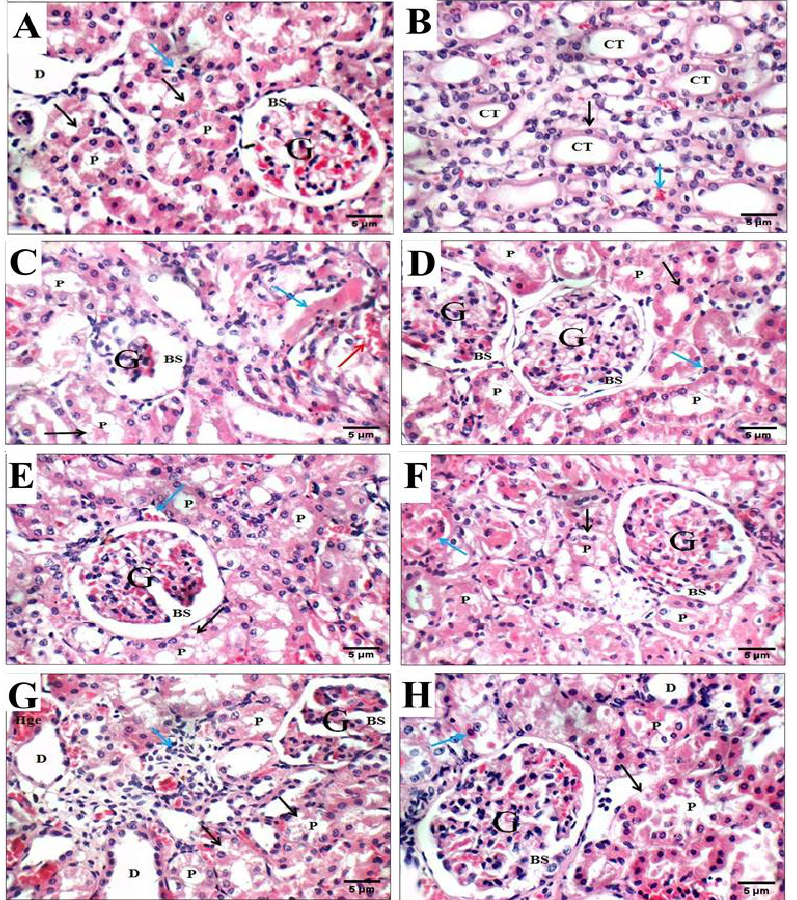
Fig. 4. The effects of fig with olive oil and date-palm fruit extracts (FOD) on the microscopic histological appearance of livers treated with different nanoparticles (NPs) for 75 days. A , higher power view of the control kidney showing average glomeruli (G) with average Bowman’s spaces (BS), average proximal tubules (P) with preserved brush borders (black arrows), average distal tubules (D), and average interstitium (blue arrow); B , FOD- treated group renal medulla showing average collecting tubules (CT) with average epithelial lining (black arrow) and average peri-tubular capillaries (blue arrow); C , SiO NPs-treated group showing atrophied glomerulus (G) with 2 widened Bowman’s space (BS), proximal tubules (P) with mildly edematous epithelial lining (black arrow), intra- tubular hyaline casts (blue arrow), and mildly congested blood vessels (red arrow); D , FOD-SiO NPs-treated group 2 showing average glomeruli (G) with average Bowman’s spaces (BS), proximal tubules (P) with average epithelial lining (black arrow), and average interstitium (blue arrow); E , Al O NPs-treated group showing average glomerulus 2 3 (G) with average Bowman’s space (BS), proximal tubules (P) with mildly edematous epithelial lining (black arrow) and mildly congested interstitial blood vessels (blue arrow); F , FOD-Al O NPs-treated group showing average 2 3 glomerulus (G) with average Bowman’s space (BS), proximal tubules (P) with mildly edematous (black arrow) and apoptotic epithelial lining (blue arrow); G , ZnO NPs-treated group showing atrophied glomerulus (G) with widened Bowman’s space (BS), proximal tubules (P) with edematous epithelial lining (black arrow), and areas of interstitial hemorrhage (Hge) with mild inflammatory infiltrate (blue arrow); H , FOD-ZnO NPs-treated group showing average glomerulus (G) with average Bowman’s space (BS), proximal tubules (P) with mildly edematous (black arrow) and apoptotic epithelial lining (blue